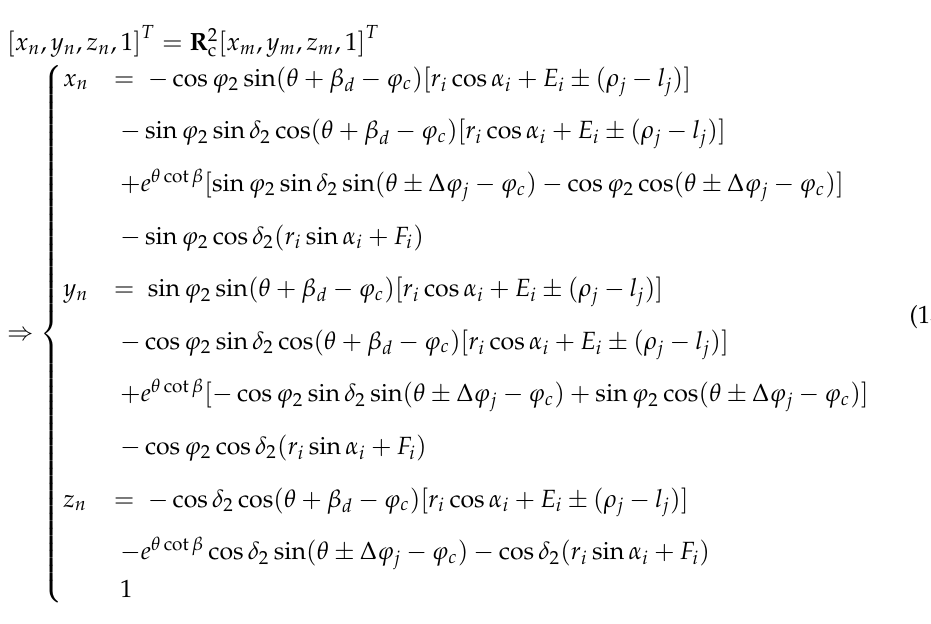
Figure 6. Coordinate relationship between tooth profile and tooth alignment curve. Equation (13) is the tooth surface equation of the internal spiral bevel gear through R c for the coordinate system The coordinate transformation matrix n the coordinate transformation of Equation pressed as: